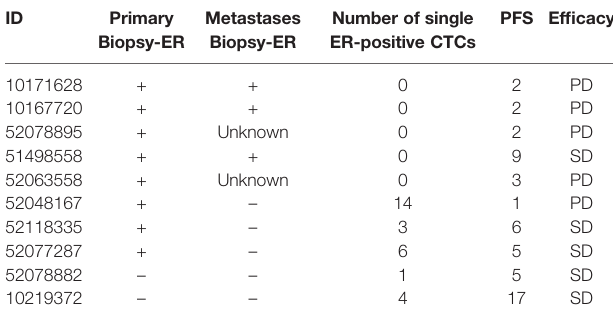
TABLE 4 | The statistics of 10 patients who had a discordant ER status between the IHC results and